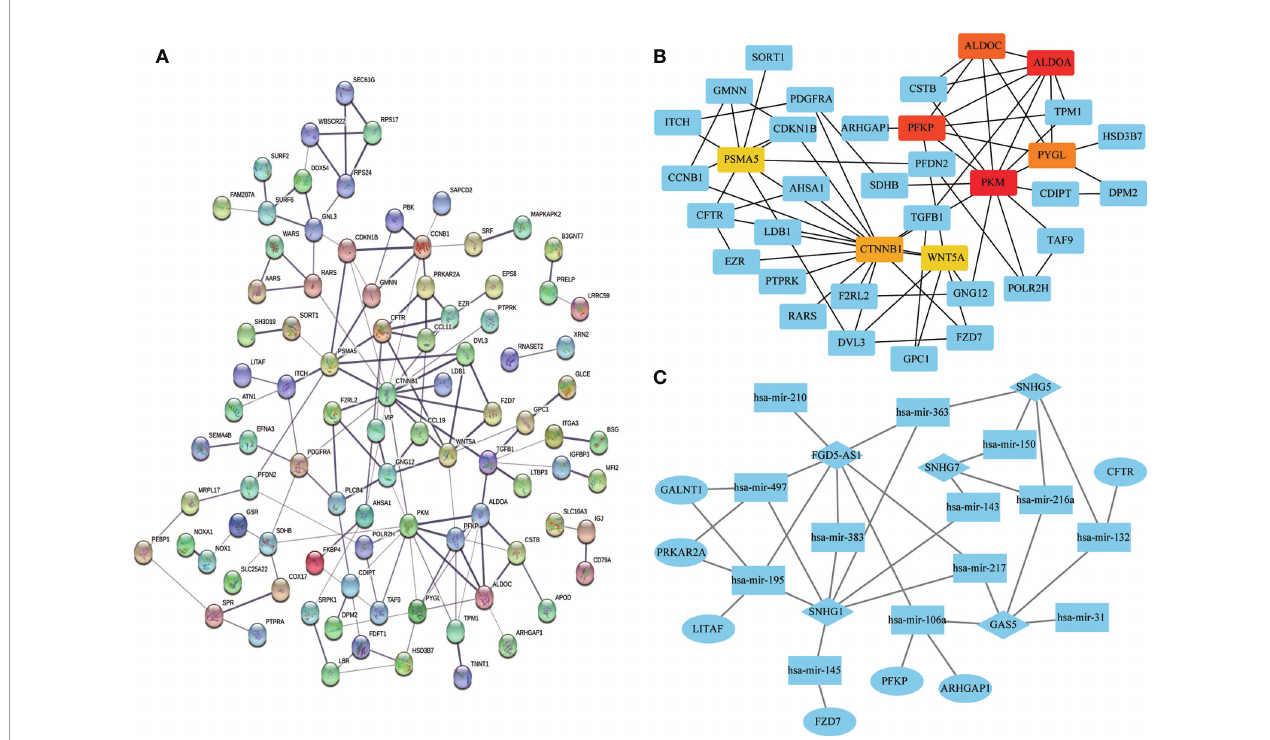
FIGURE 9 | Visualization of protein-protein interaction (PPI) and ceRNA networks. (A) PPI network of 136 genes associated with colon adenocarcinoma/rectum adenocarcinoma (COAD/READ). Each node represents a gene. (B) Hub genes in the PPI network. Red and yellow nodes represent eight hub genes. (C) CeRNA network based on differentially expressed mRNAs, miRNAs, and lncRNAs. Ovals, diamonds, and squares represent mRNAs, lncRNAs, and miRNAs,